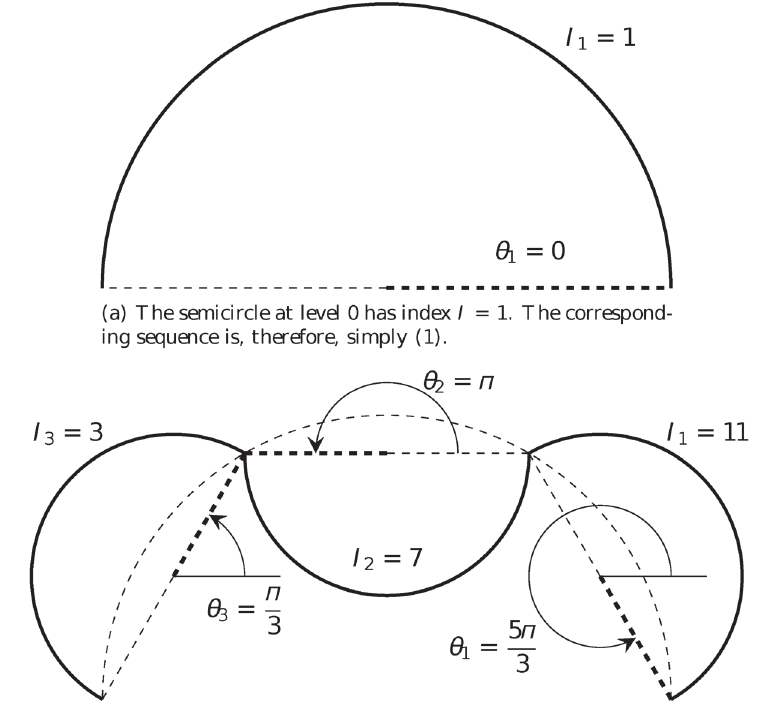
Fig 6. Sequences associated with the crab fractal at different levels of construction. The rule is: α = π , n = 3 and ω = ( − 1, 1, − 1). The relation between the angle θ i and the index I i is given by Eq. (1).